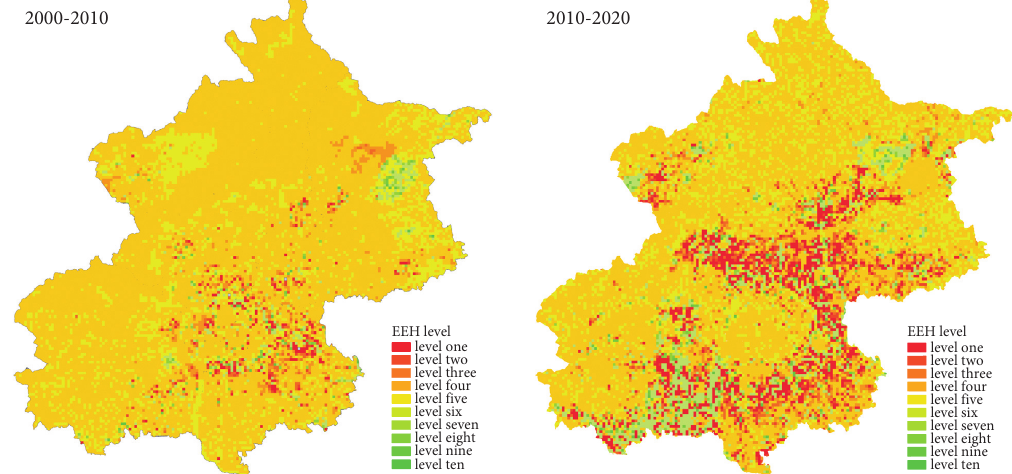
Figure 10: EEH change of township units in the second green isolation area